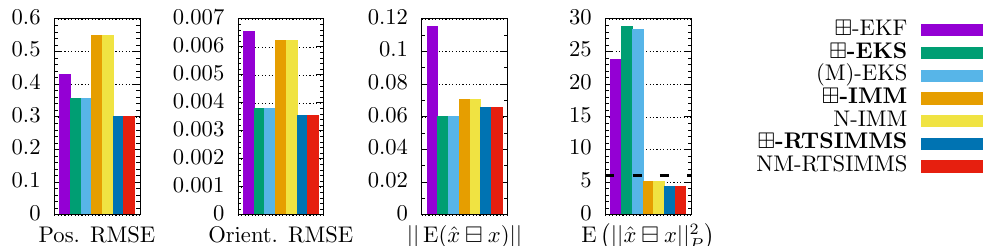
Figure 2. RMSE and consistency comparison for aircraft tracking in 100 Monte Carlo runs. The opti- mal value is 0 for E ( ˆ x (cid:12) x ) and 6 for E (dashed || || (cid:0) (cid:1)